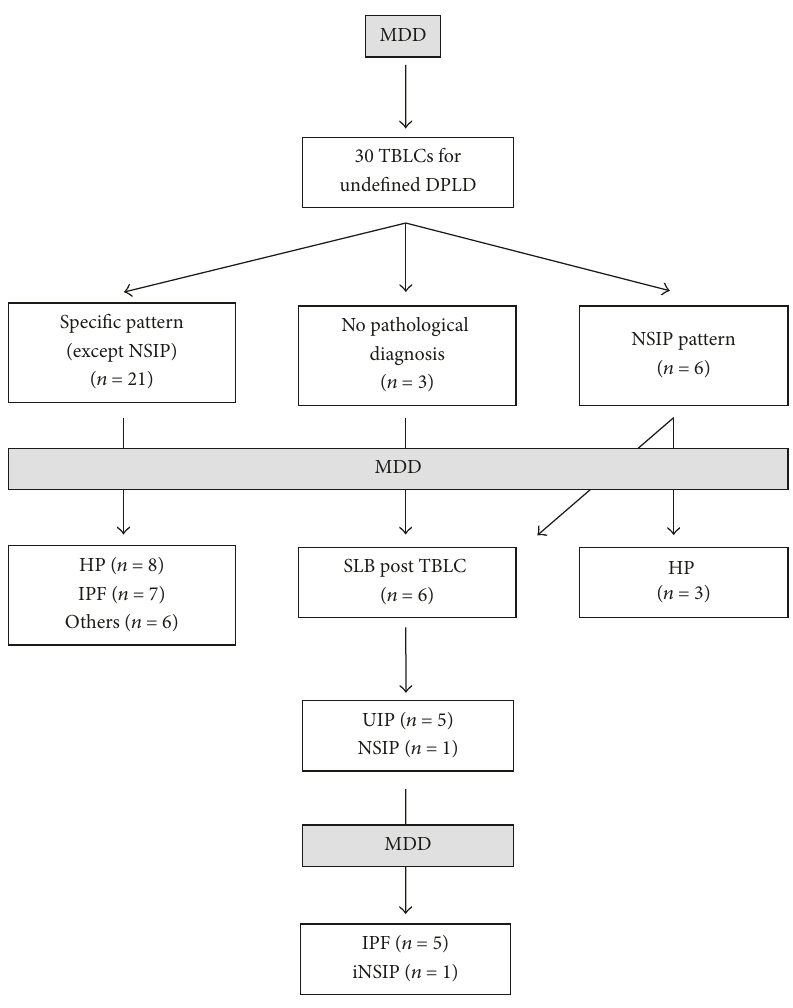
Figure 2: Detailed diagnoses obtained after TBLCs (and SLBs when applicable).